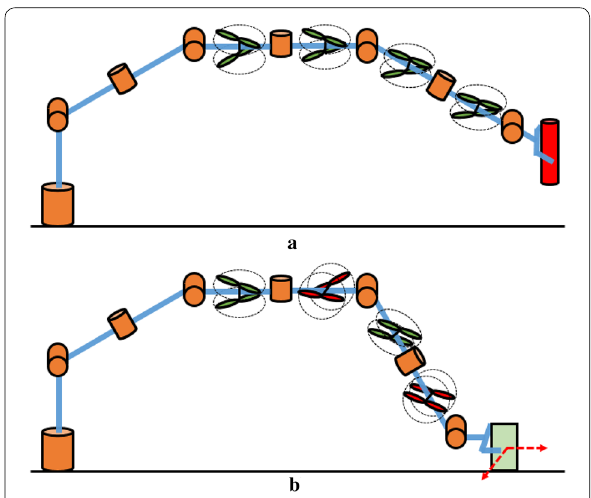
Fig. 2 a Flying watches help a long arm pick up an object. b Flying watches help a long arm push debris on the ground in different directions. Rotation axes of red flying watches are on horizontal planes. Rotation axes of green flying watches are on vertical planes